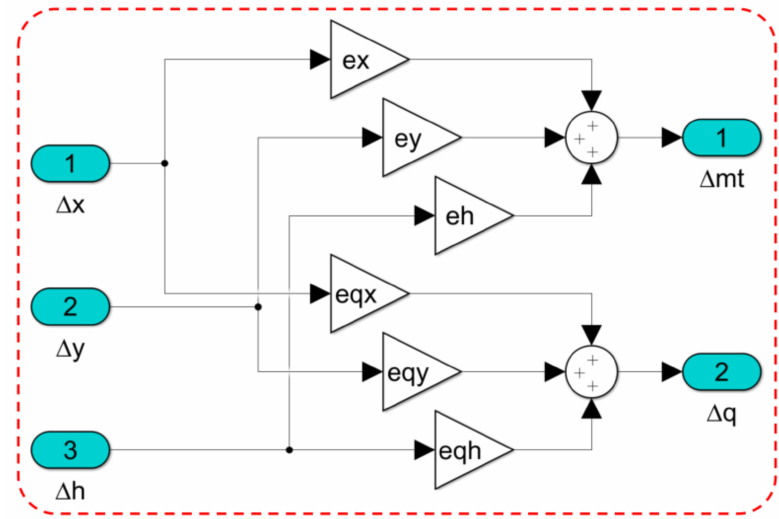
Figure 7. Simulation model of hydraulic turbine.